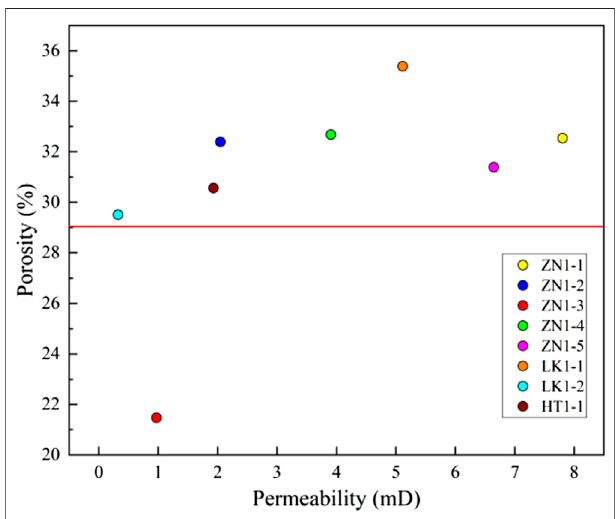
FIGURE 15 | The relationship between porosity and permeability.